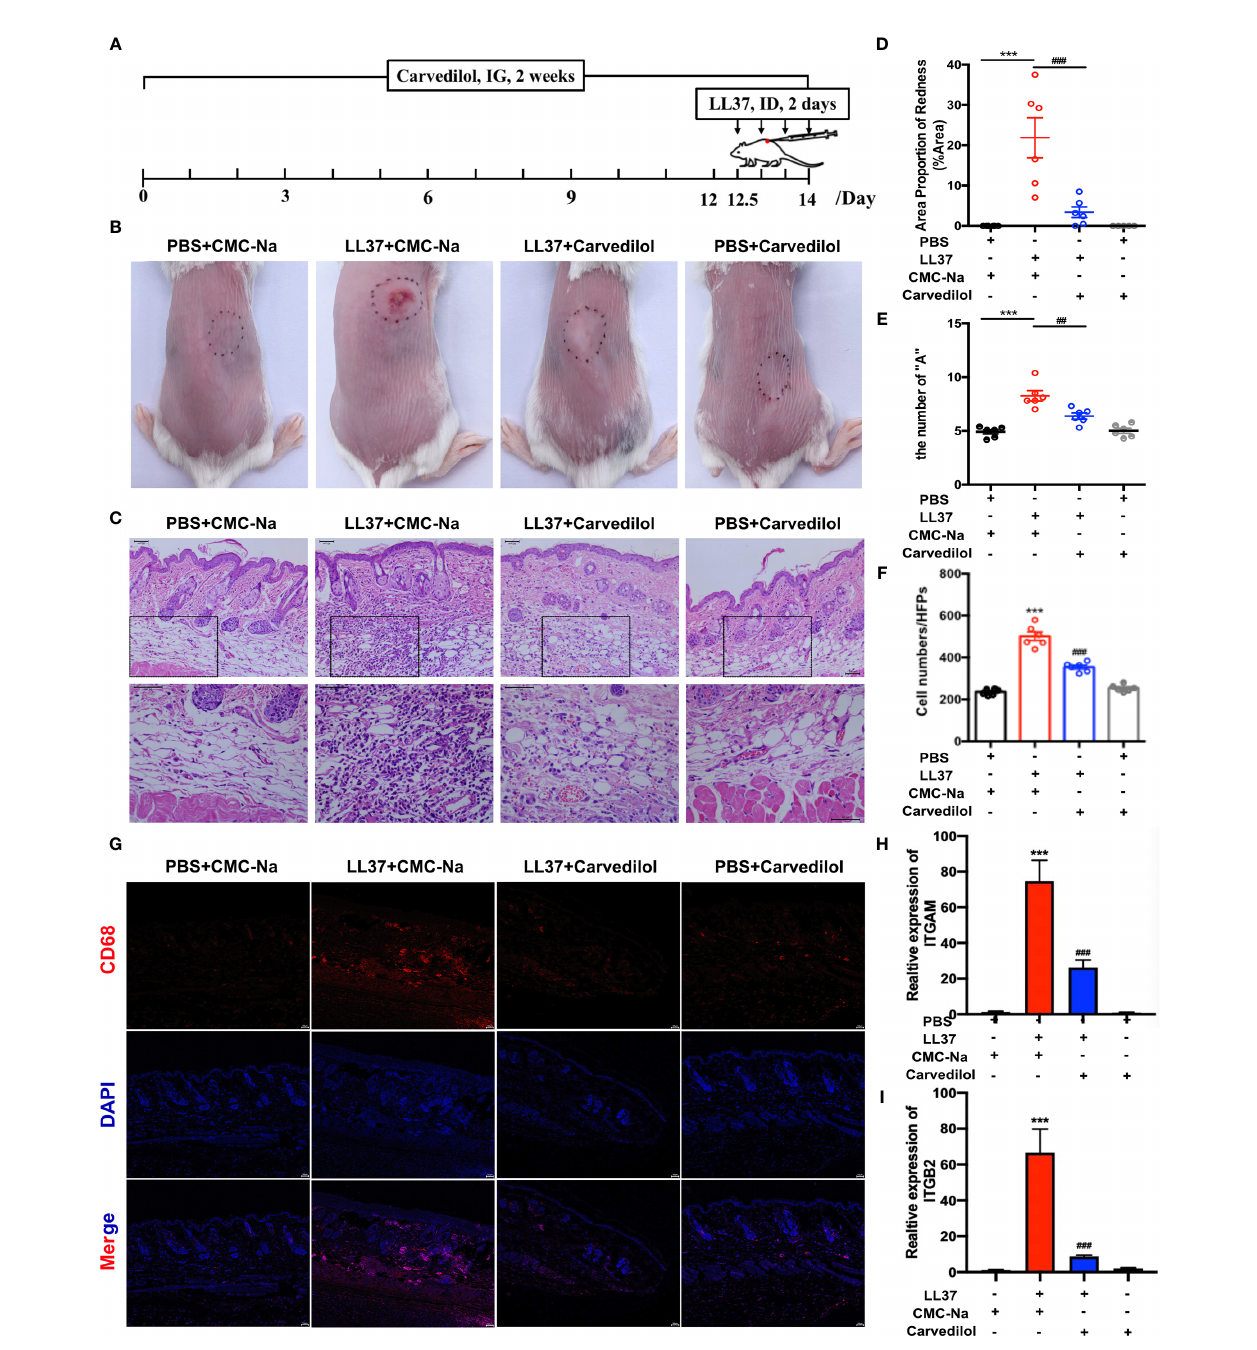
FIGURE 2 | Carvedilol alleviates rosacea-like in fl ammation and macrophage in fi ltration induced by LL-37 in mouse skin. (A) PBS or cathelicidin LL-37 (50 m L, 320 mM) was injected intradermally into BALB/c mice to induce rosacea-like in fl ammation. Carvedilol (40 mg/kg) or CMC-Na was administrated by gavage for 14 days and animals observed 12 h after the last injection. (B, C) Skin manifestation of different groups. Obvious erythema was observed in the LL-37+CMC-Na group whereas pretreatment of carvedilol alleviated the reaction induced by LL-37 as shown in the LL-37+carvedilol group; conversely, carvedilol did not cause any obvious changes to the skin as shown in the PBS+carvedilol group. (D) The value of A* determined with a LAB colorimeter. (E, F) HE staining of skin samples from the four groups reveals obvious in fl ammation in the skin of the LL-37+CMC-Na group, which was signi fi cantly decreased in the LL-37+carvedilol group (n = 6). (G) Immuno fl uorescence staining of CD68 revealed that macrophages were accumulated in the LL-37+CMC-Na group, which was alleviated by pretreatment of carvedilol in the LL-37+carvedilol group. In comparison, PBS or carvedilol alone did not result in obvious changes (n = 4). The pictures were taken under ×100, ×200, and ×400 magni fi cation. (H, I) Statistical analysis of the results of RT-qPCR of the genes for ITGAM, and ITGB2 (n = 4). ***P < 0.001, ### P <